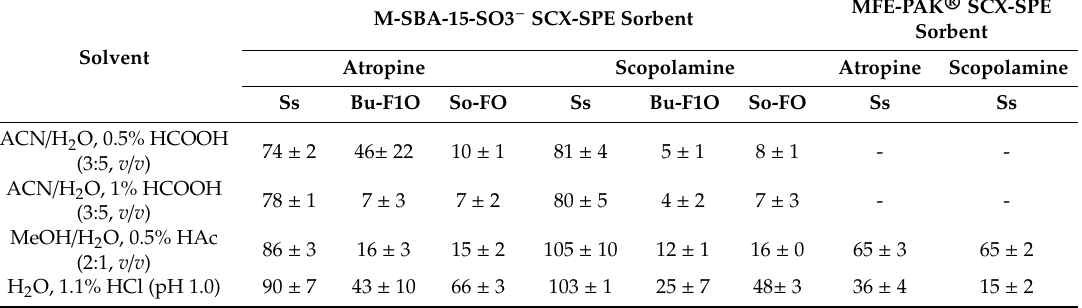
* SPE experimental conditions - Sorbent amount: 50 mg. Loading: 8 mL of 0.1 mg / L TAs standard solution or sample extracts from flours spiked with 0.1 mL of a 1 mg / L TAs standard solution. Elution: 3 mL of MeOH and 2 × 3 mL